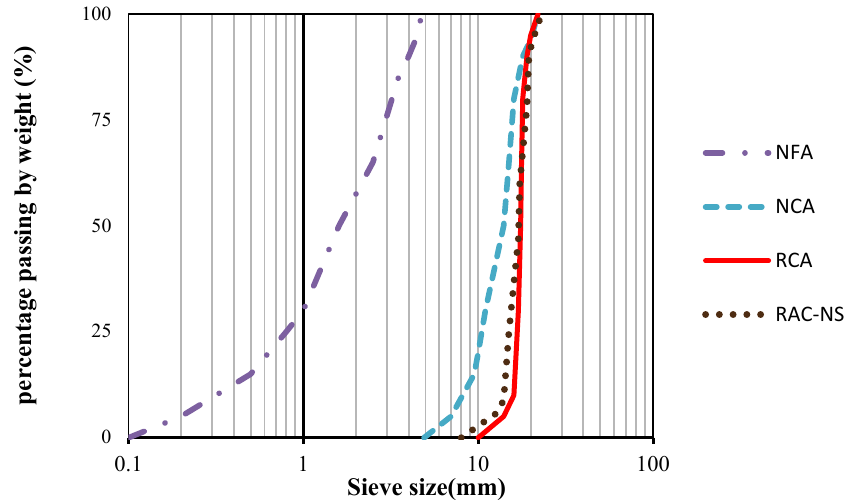
Figure 1. Grading curve of natural aggregates (NA) for the three groups, recycled coarse aggregates (RCA) of group two, recycled coarse aggregates containing nano-silica (RCA-NS) of group three.